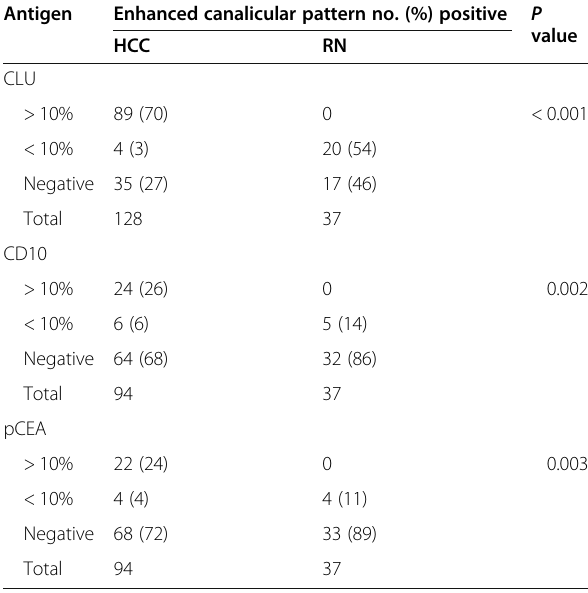
Table 1 Comparison of CLU, CD10, pCEA immunoreactivity between HCC and RN